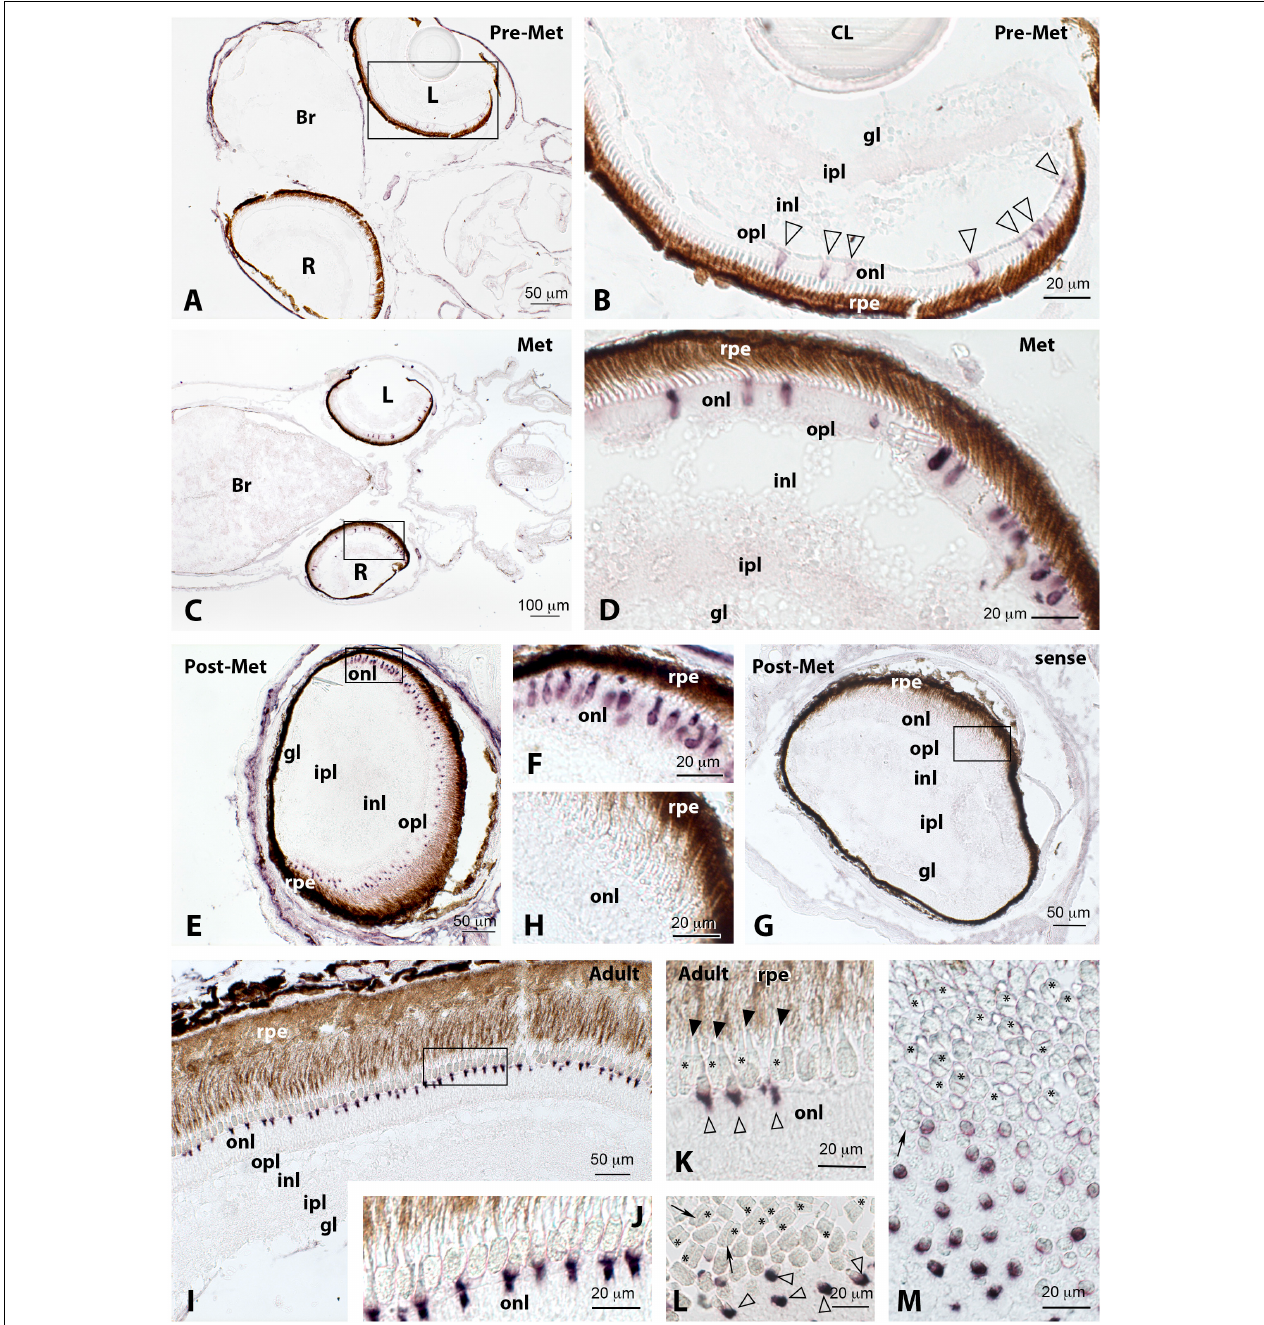
FIGURE 6 | Localisation of blue cone opsin ( sws2 ) expression in the retina of pre-metamorphic (Pre-Met; A,B ), metamorphic (Met; C,D ), post-metamorphic (Post-Met; E–H ), and adult (I–M) Senegalese sole specimens revealed by in situ hybridisation. All the photomicrographs represent antisense sections, with the exception of panels (G) and (H) , which show sense control sections. Squares in panels (A,C,E,G,I) mark the areas magnified in photomicrographs (B,D,F,H,J) , respectively. Note the low number of positive cells and faint labelling of cones in pre-metamorphic specimens ( B , white arrowheads), how the intensity of this labelling increases in metamorphic animals (C,D) , and subsequent increase in the number of labelled cones in post-metamorphic (E,F) and adult (I,J) retinas. In the adult retina, sws2 expression appears evident at the base of inner segments of single cones (white arrowheads in panels K,L ). In contrast, double cones (asterisks in panels K–M ), which exhibit their characteristic double outer segments (black arrowheads in panel K ), were devoid of labelling. Most of the unlabelled double cones exhibited straight partitions (L,M) , although a few of them showed a bent partition (black arrows in panel L ). Black arrow in panel (M) marks an unlabelled triple cone revealed in a radial section. (L,M) photomicrographs represent oblique and tangential sections, respectively, whereas the remaining pictures corresponded to radial sections. CL, crystalline lens. For other abbreviations, see the legend in Figure 2 . Scale bars represent 20 µ m in panels (B,D,F,H,J–M) ; 50 µ m in panels (A,E,G,I) ; and 100 µ m in panel (C)